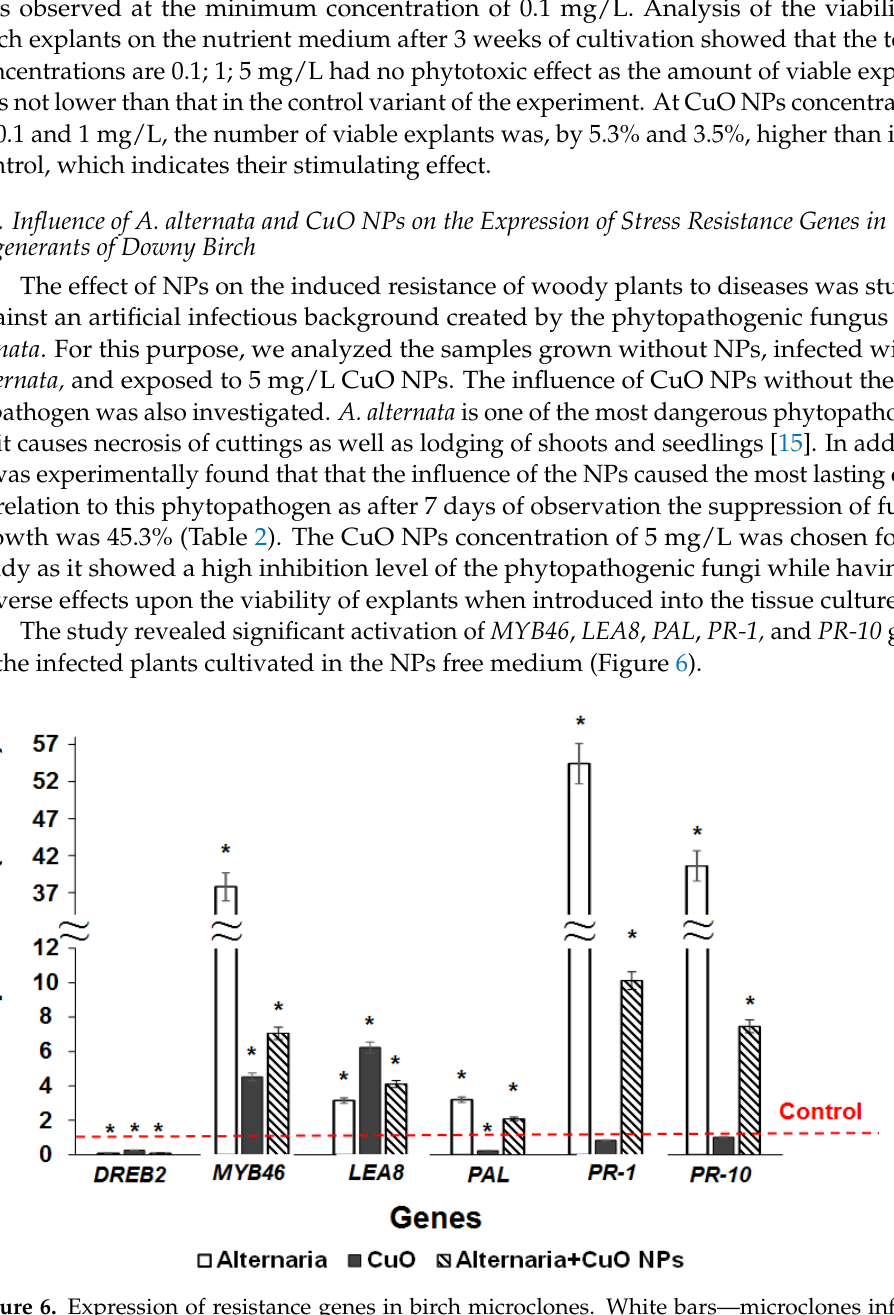
Figure 6. Expression of resistance genes in birch microclones. White bars—microclones infected with A. alternata , gray bars—plants cultivated on the medium containing 5 mg/L CuO NPs, striped bars—microclones infected with A. alternata and exposed to 5 mg/L CuO NPs, and control—plants on the medium without NPs and not exposed to the phytopathogen (* is significant deviation from control). The level of MYB46 , PAL , PR-1, and PR-10 expression was lower under combined exposure to NPs and A. alternata than under exposure to a single phytopathogen.